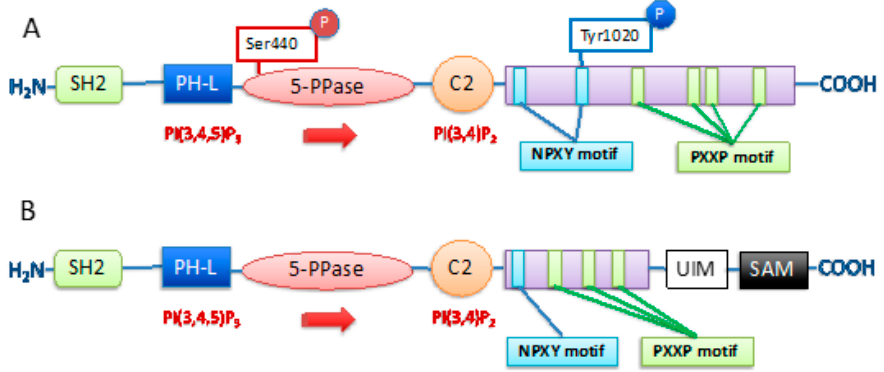
Figure 2. SHIP protein structure and active sites SHIP1 and SHIP2 are multidomain proteins constituted of: SH2 domain, PH-L domain, 5’-phosphatase catalytic domain, C2 domain and C-terminal domain containing PXXP and NPXY motifs. ( A ) SHIP1 has phosphorylation sites on Serine 440 (Ser440) and Tyrosine 1020 (Tyr1020) that regulate respectively its activation and ubiquitination. ( B ) SHIP2 has a ubiquitin interacting motif (UIM) and a sterile alpha motif (SAM) domain, not present in SHIP1.